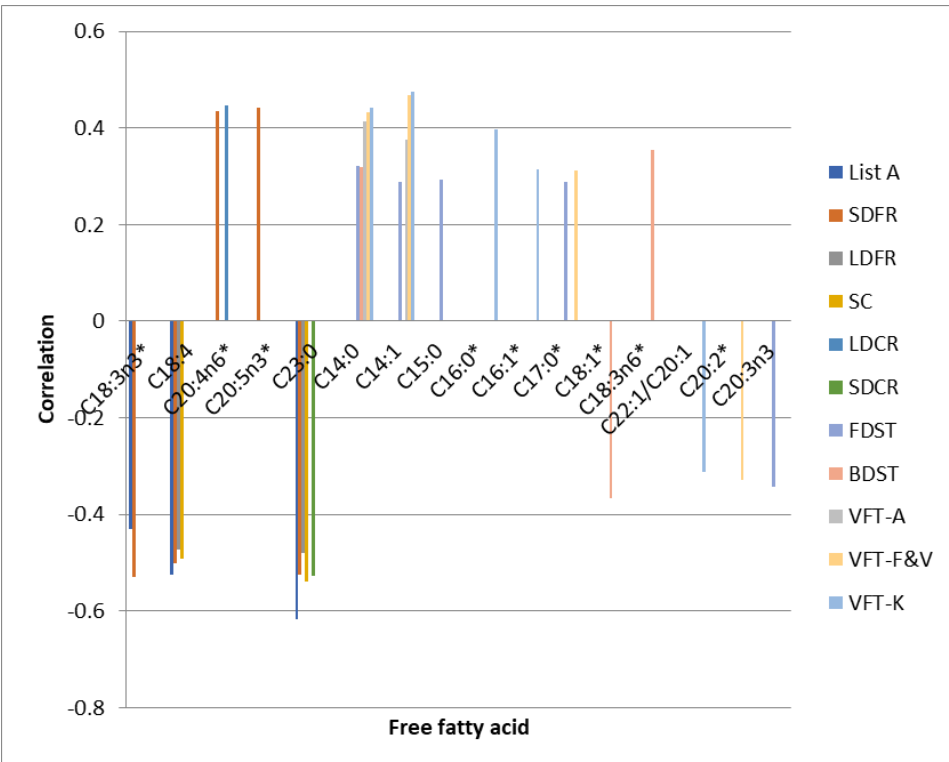
Figure 2. Correlations between FFAs and neuropsychological test scores performed on the 7th day. * statistically significant differences between the FFA level in the control and experimental group.